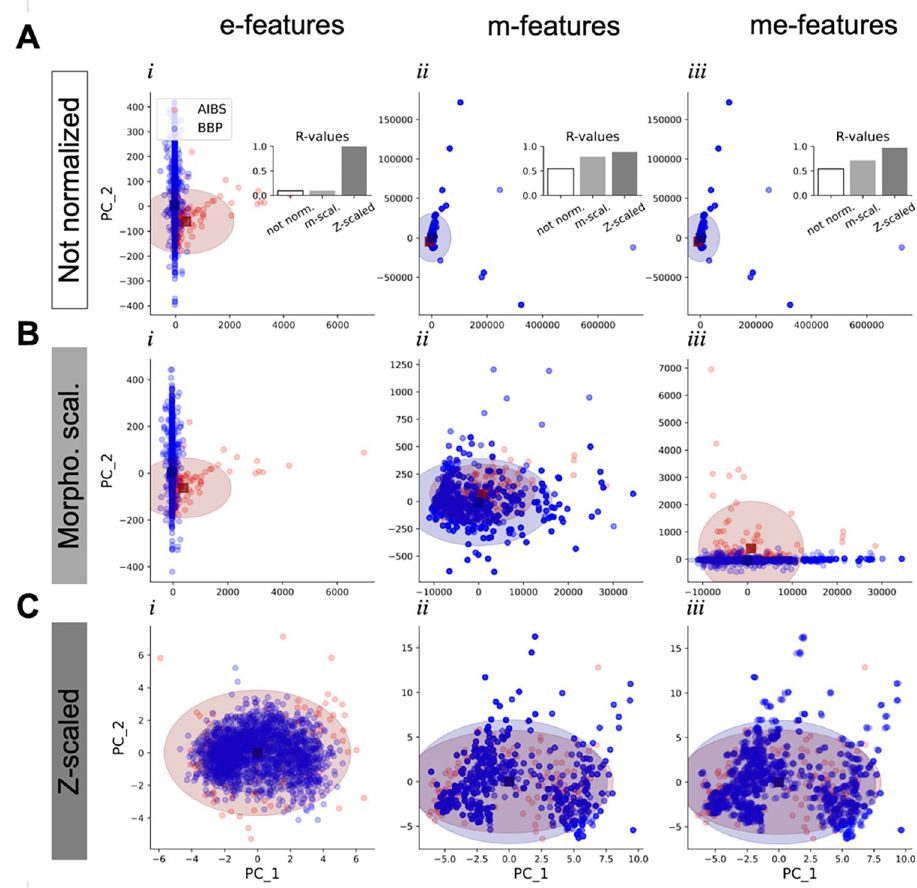
Fig 2. Preprocessing for cross-dataset overlap optimization. A. PCA visualization of the e-features ( i ), m-features ( ii ) and me-features ( iii ) spaces without normalization on the two first components (PC1 and PC2). AIBS cells are in red and BBP cells are in blue. Colored ellipses are centered on centroids (square dots) and radii are computed as 2 standard deviations. Insets are bar plots of R-values computed in m-features, e-features and me-features spaces without morphological scaling (white), with morphological scaling (light grey) and after (dark grey) preprocessing (Z-scaling). B and C. Same as above but with morphological scaling and before (B) or after (C) preprocessing (Z-scaling).